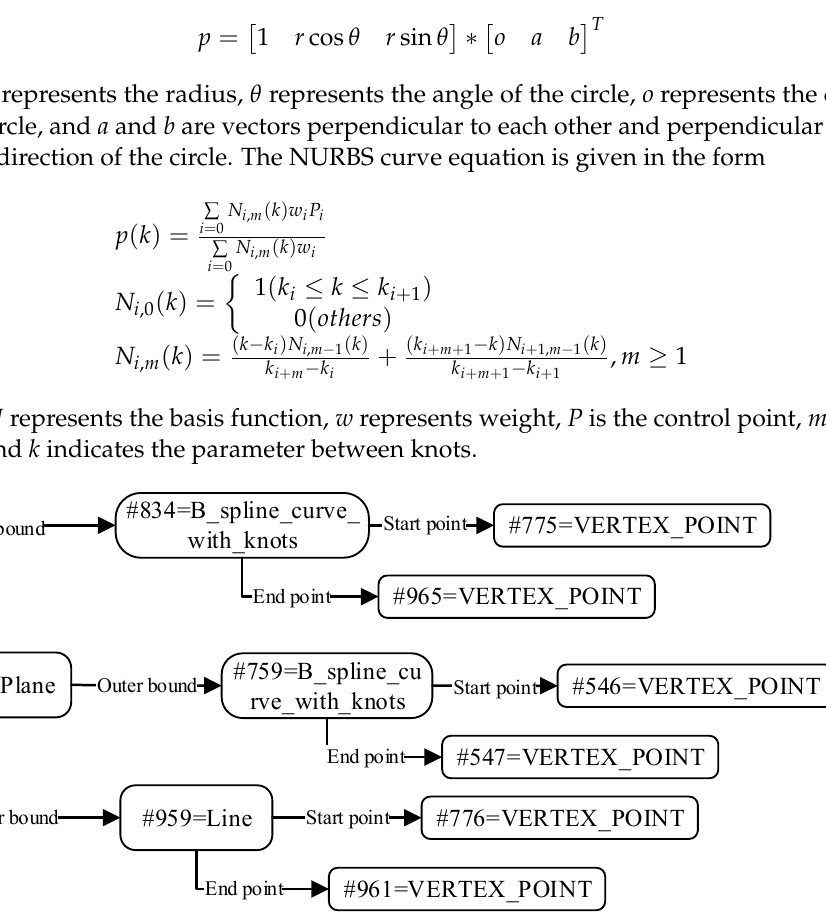
Figure 2. The entity information of a particular functional surface in STEP file.